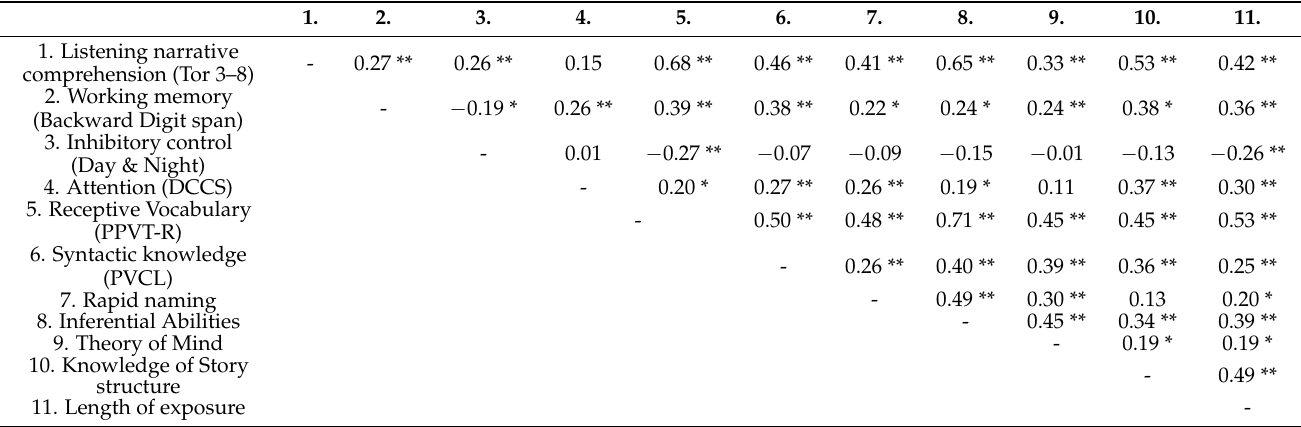
Table 2. Correlations among